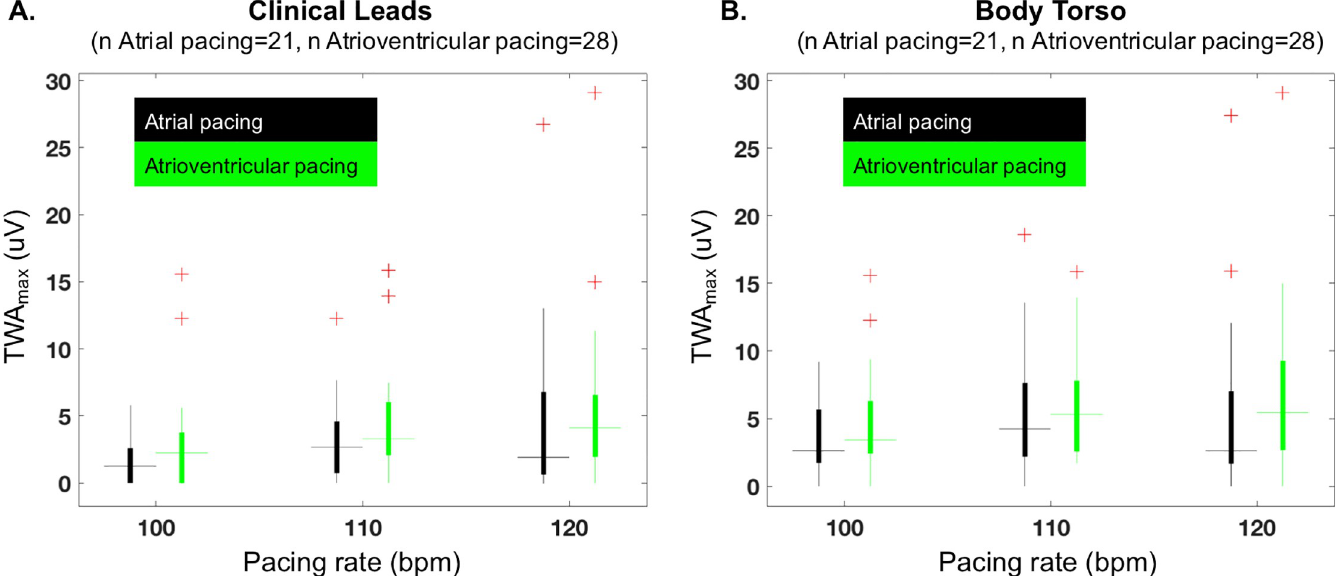
Fig 2. TWA max is compared between atrial and atrioventricular pacing for clinical leads ( A ) and body torso ( B ). TWA max is similar between atrial and atrioventricular pacing, regardless of clinical leads or body torso sampling. + indicates outliers.